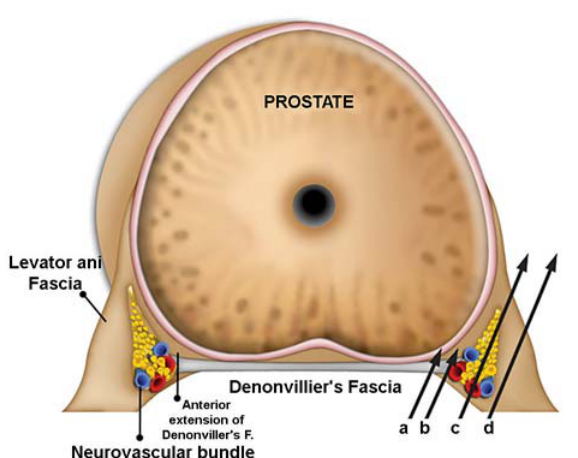
Figure 5 – Grades of neurovascular bundle